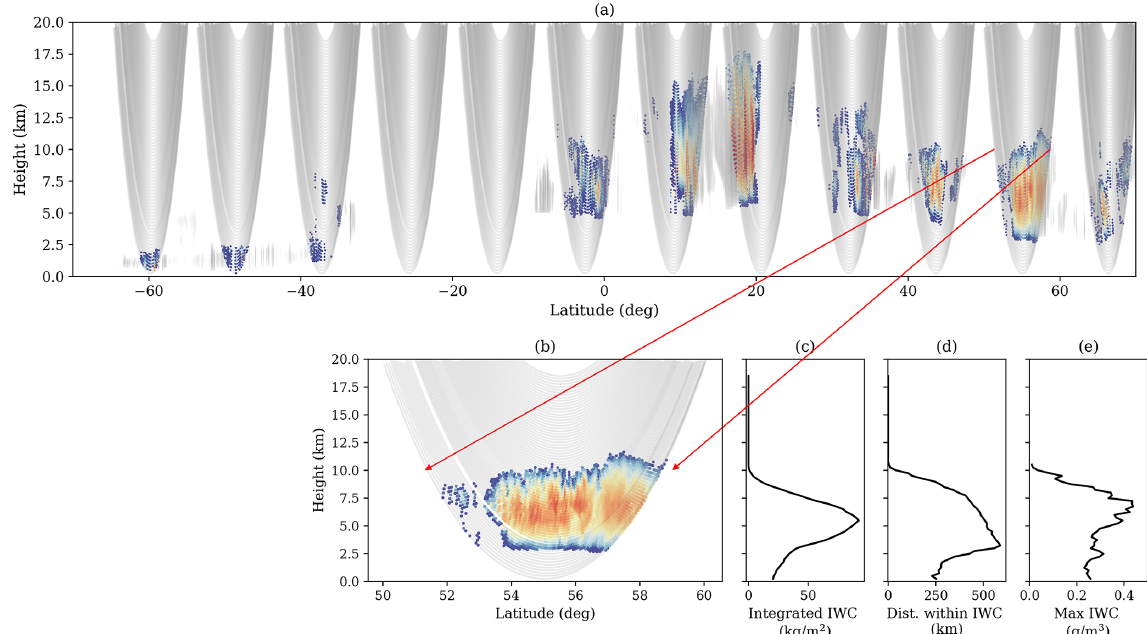
Figure 1. Example of half of the CloudSat orbit observations (in this case, derived ice water content), with the RO rays overlapped. The CloudSat orbit granule is 01075. In panel (a) only the CloudSat ice water content being overlapped by RO rays is colored. IWC not being overlapped by RO rays is in grayscale. Panel (b) shows a more detailed image of the CloudSat-derived ice water content interpolated into the RO rays, which corresponds to one of the slices shown in panel (a) and is indicated by the red arrows. In panels (c–e) the corresponding integrated ice water content, distance traveled by the ray within the influence of IWC, and the maximum IWC encountered along the ray, respectively, are shown as a function of each ray tangent